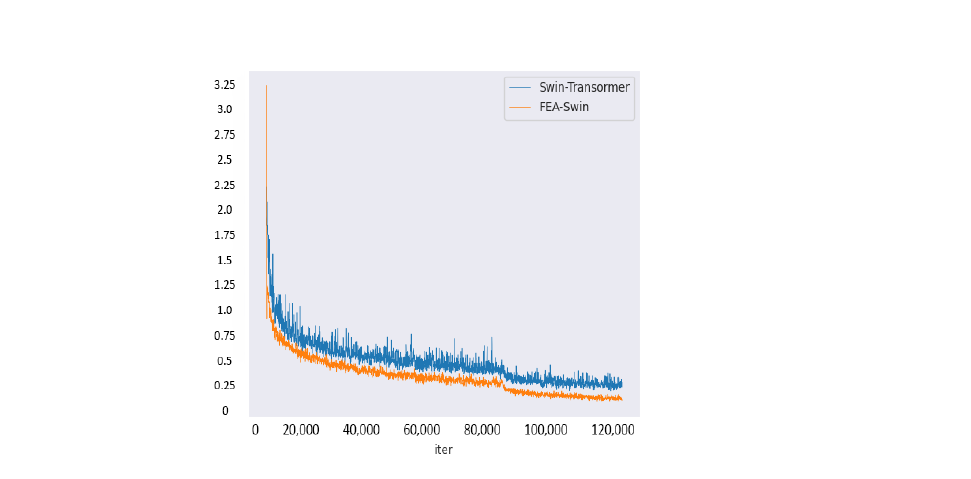
Figure 9. The loss curve during training on the Visdrone dataset. The blue curve represents Swin Transformer and the orange line represents FEA-Swin.